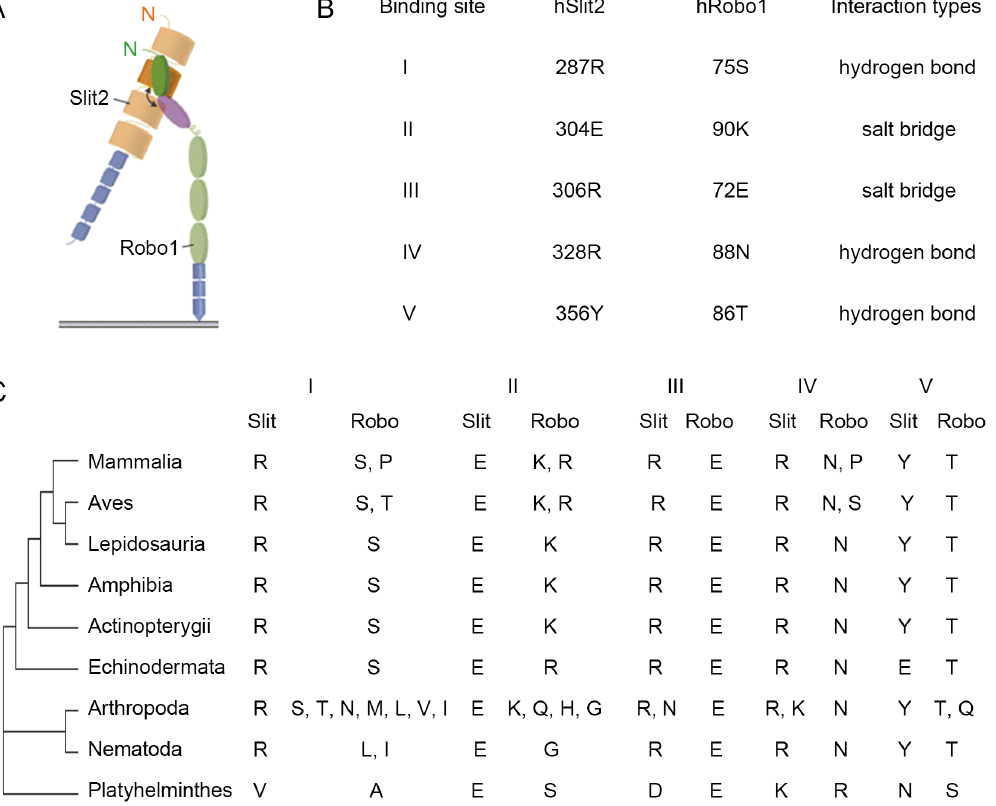
Table 1. Pearson’s correlation coefficient of evolutionary distances between Slit and Robo in vertebrates.